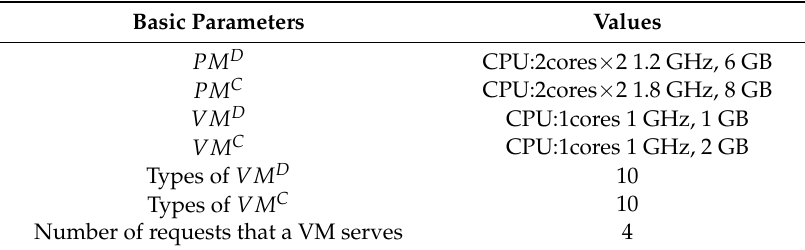
Table 1. The basic parameters for